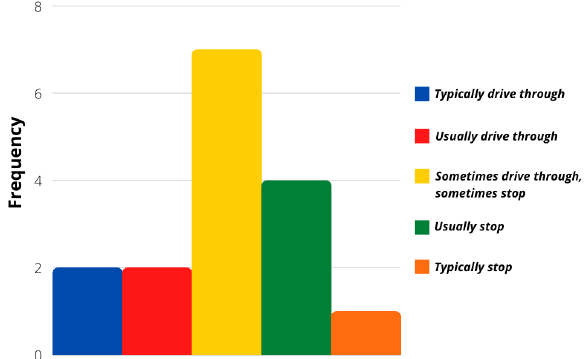
Figure 11. Question 60